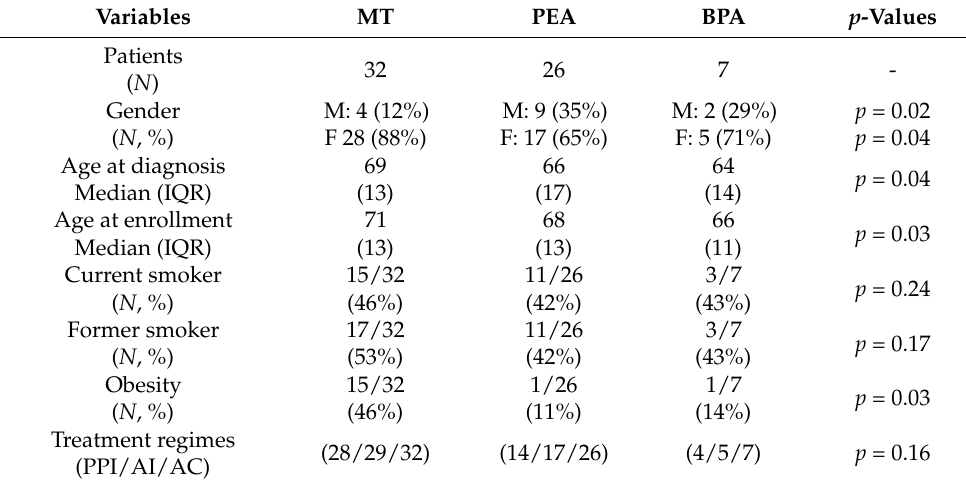
Table 1. Characteristics of the study population at